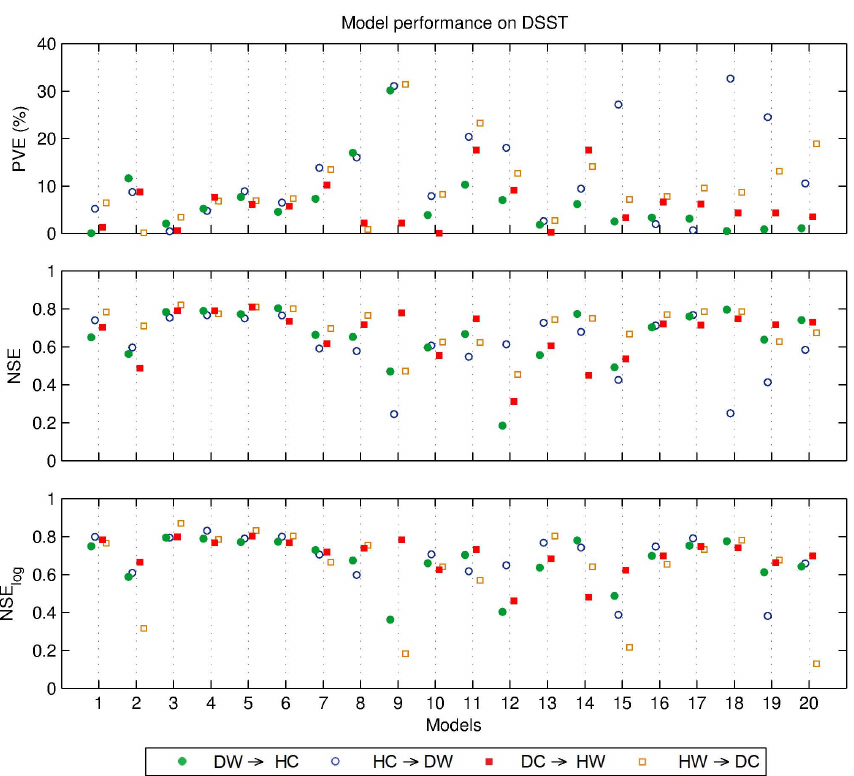
Fig. 9. Performance in validation (PVE, NSE and NSE log criterion) for the four DSST on the Schlehdorf catchment (SLD). Negative values for NSE not